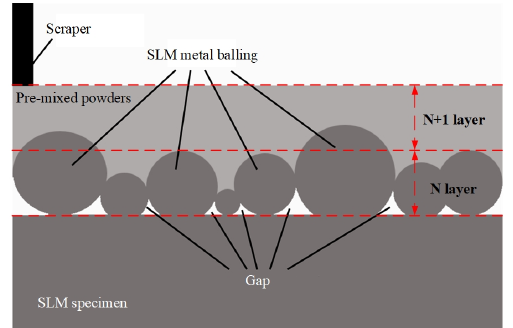
Figure 6. The SEM images of Al 0.5 CoCrFeNi HEAs at different laser power:( a ) 160 W, ( b ) 200 W, ( c ) 240 W, ( d ) 280 W, ( e ) 320 W at a scan speed of 800 mm/s and hatch spacing of 60 μm, and ( f ) image of the selected area illustrated by a square in ( e ) and the elemental distribution maps of the area.